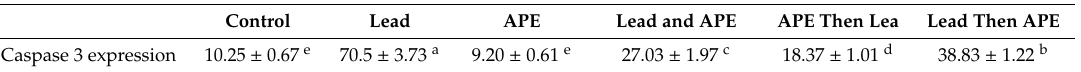
Figure 4. Immunohistochemical analysis of activated caspase 3 in liver tissue of rats. ( A ) Liver of control animal showing mild expression of caspase 3 within the hepatocytes (arrow indicates nuclear expression), cleaved form of caspase 3 IHC, bar = 50 μ m, ×200. ( B ) Liver of lead-intoxicated animal showing marked expression of caspase 3 of both cytoplasmic and nuclear expression within the hepatocytes (arrows), cleaved form of caspase 3 IHC, bar = 50 μ m, ×200. ( C ) Liver of normal animal treated with Azolla showing mild expression of caspase 3 within the hepatocytes (arrow indicates cytoplasmic expression), cleaved form of caspase 3 IHC, bar = 50 μ m, ×200. ( D ) Liver of animal treated with both lead and Azolla showing decrease the expression of caspase 3 (arrow), cleaved form of caspase 3 IHC, bar = 50 μ m, ×200. ( E ) Liver of diseased animal pretreated with Azolla showing mild cytoplasmic expression of caspase 3 (arrows), cleaved form of caspase 3 IHC, bar = 50 μ m, ×200. ( F ) Liver of diseased animal treated with Azolla showing marked decrease in caspase 3 expression within the hepatocytes (arrow), cleaved form of caspase 3 IHC, bar = 50 μ m, ×200. The labelling indices of caspase 3 were expressed as the percentage of positive cells per total 1000 counted cells in about 10 high-power fields. Table 7. E ff ects of lead and / or Azolla Pinnata ethanolic extract (APE) on the expression of caspase 3 in hepatic tissues of